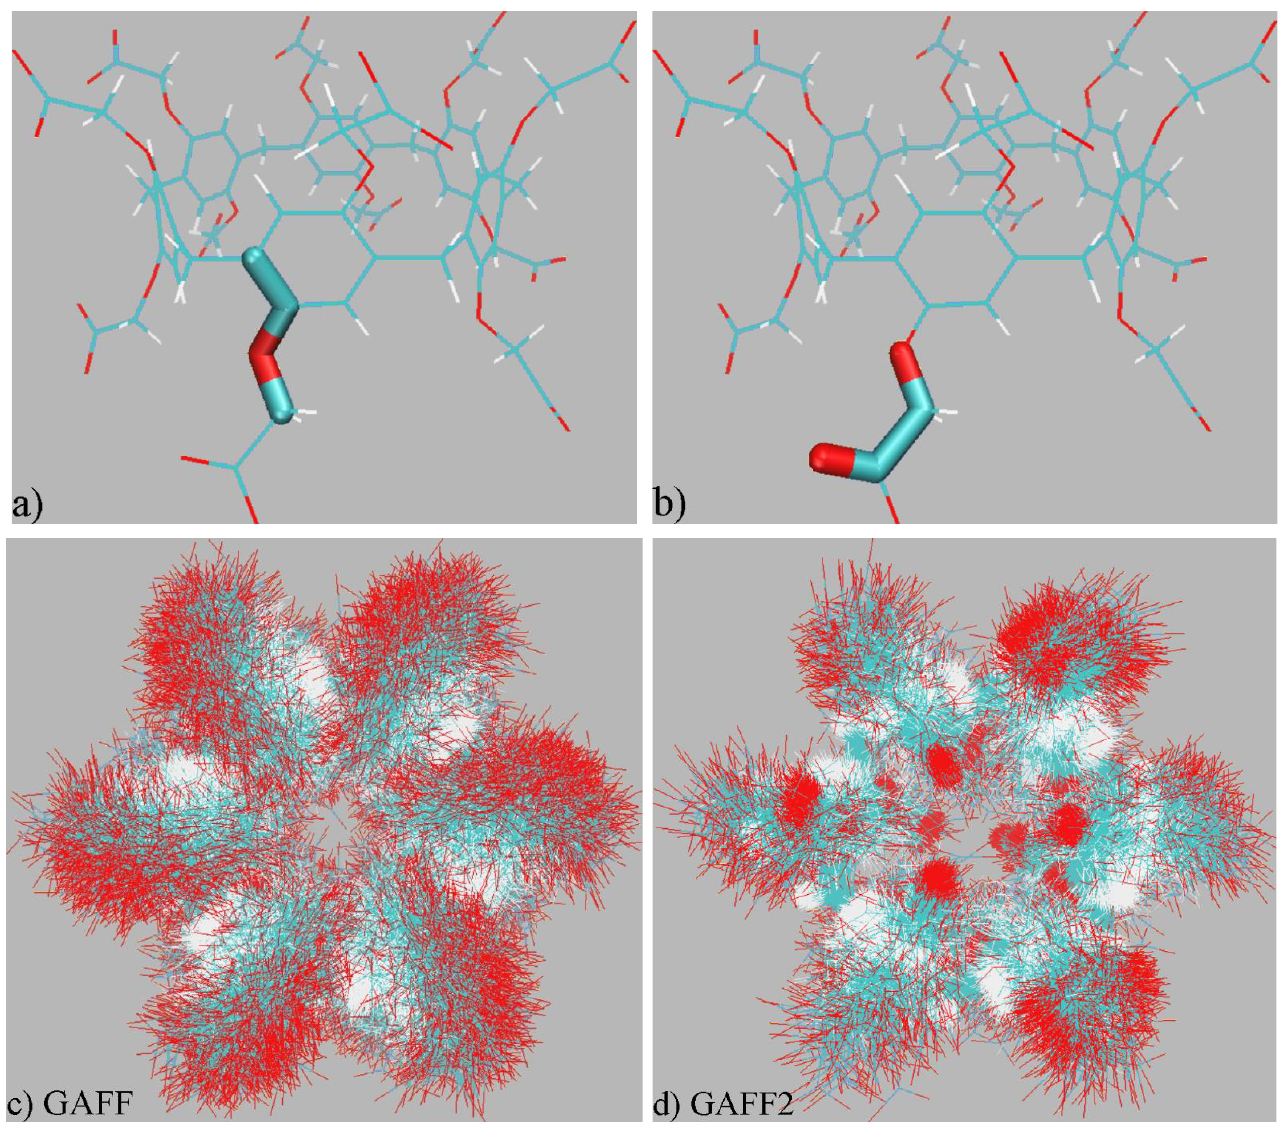
Figure 1. ( a , b ) Illustration of torsional terms that exhibit noticeable differences in the two GAFF versions. The GAFF and GAFF2 definitions of the ( a ) torsional term maintaining the planar structure share the same periodicity and phase, but the barrier height in GAFF2 is elevated by a factor of ~2 compared with GAFF. There is no explicit definition of the ( b ) torsion barrier in GAFF, but in GAFF2 this torsional interaction is defined by three Fourier-series terms with different periodicities (1, 2, and 3), phases, and barrier heights. The other five torsional potentials sharing the same defini- tion under GAFF and GAFF2 are presented in Figure S1. ( c , d ) Superpositions of the host structure in 500-ns explicit solvent sampling under GAFF derivatives. The rotation of -CH 2 -COO − tails exhibits some directional preference under GAFF2, while under GAFF a rather flexible dynamic behavior is